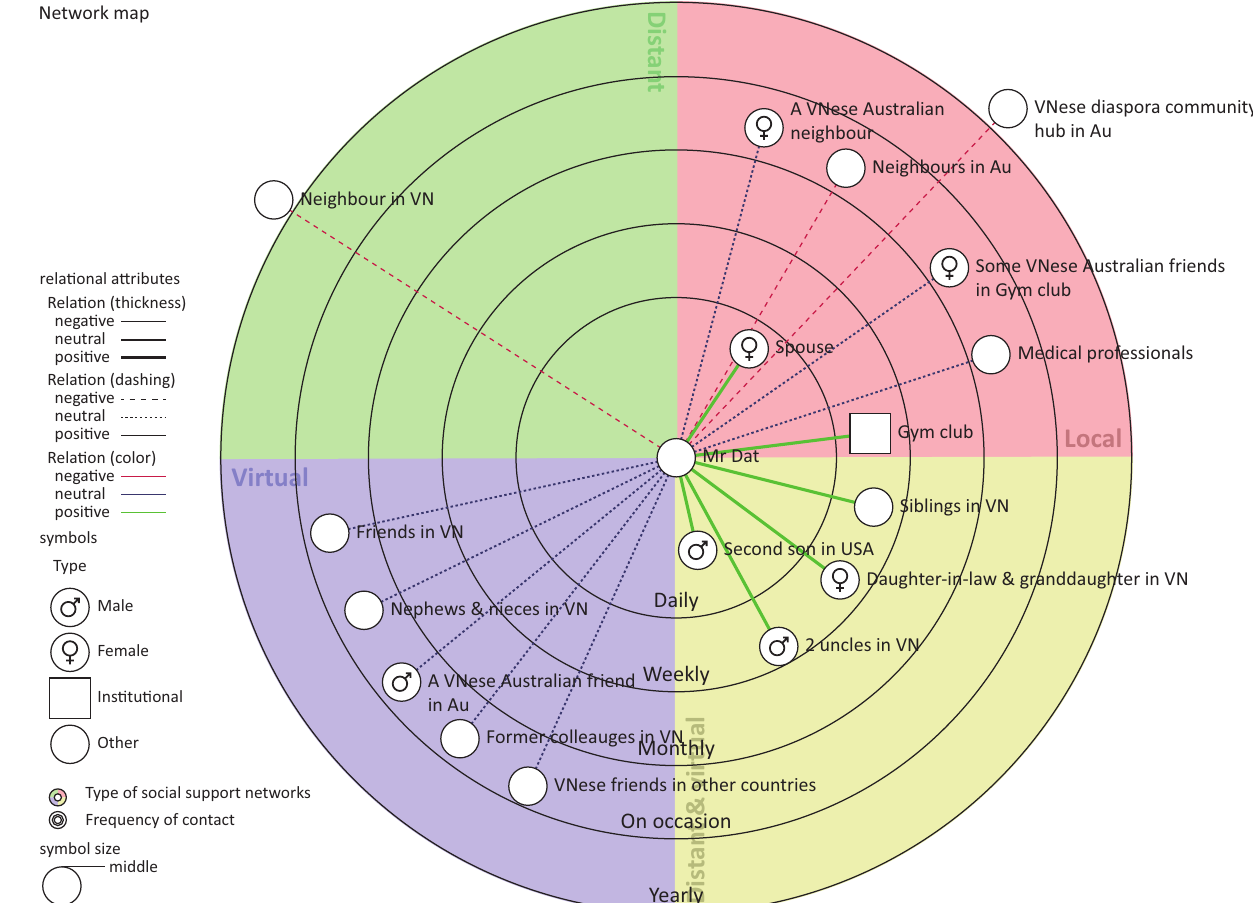
Figure 2. Illustration for digital kinning practices of a grandparent